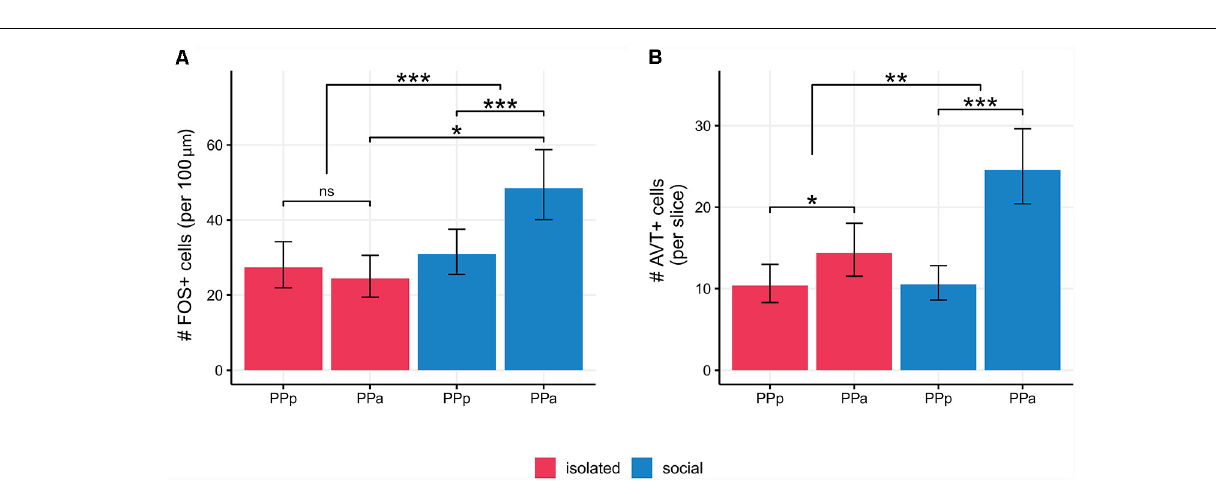
We quantified the number of FOS+ cells per 100 µ m 2 in PPa and PPp sections of the POA in social and isolated males ( Figure 4A , Table 1 ). The density of FOS+ cells in PPa and PPp is different between experimental conditions [Generalized linear mixed model (Poisson). Interaction term: condition × POA section: Wald’s χ 2 ( = 23.99; p = 9.7 × 10 − 7 ; Figure 4A , Table 1 1 )